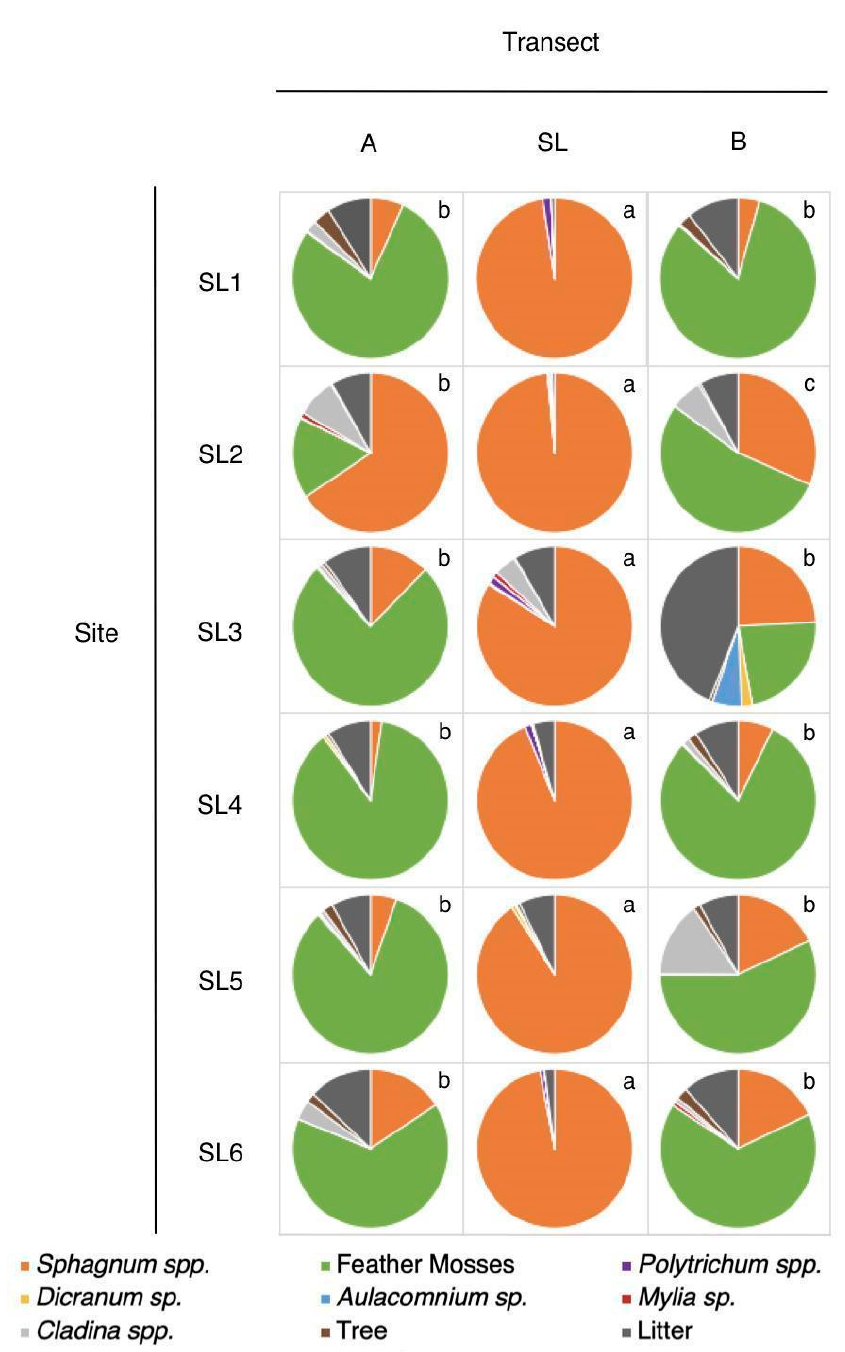
Figure 1. Mean percent ground cover composition of quadrats ( n = 15) per transect ( n = 3) at each site. Transects ‘A’ and ‘B’ are located in the adjacent peatland on opposite sides of the seismic line containing the ‘SL’ transect. Letters indicate significant (p < 0.01) differences in Sphagnum ground cover percentage between transects at each site, with no comparison amongst sites.